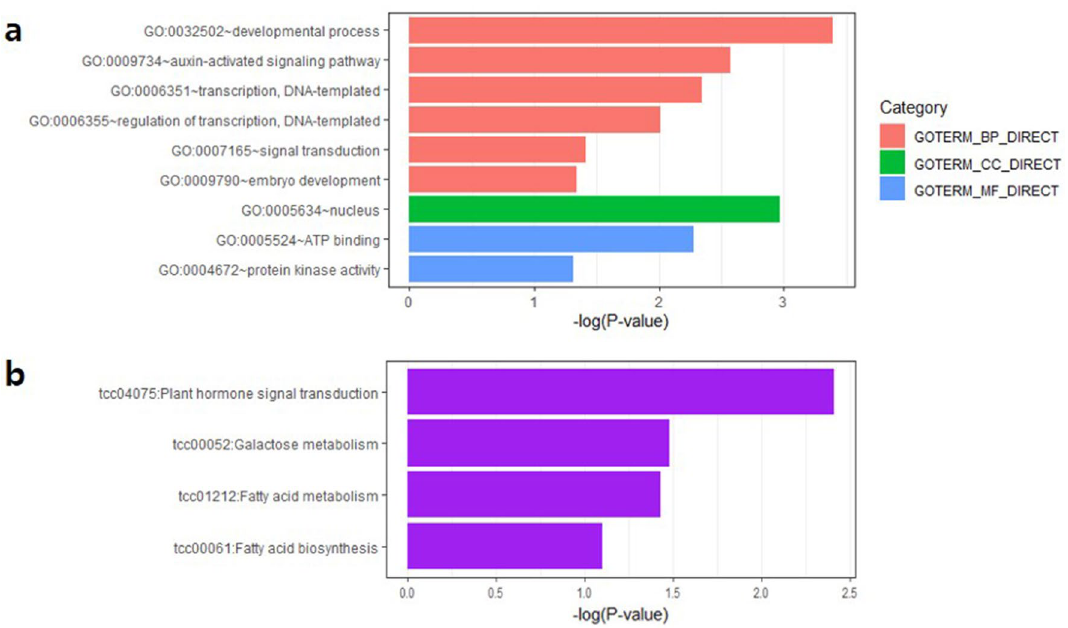
Figure 4. GO and KEGG enrichment analyses. ( a ) Assignment of DEGs into the GO categories ( b ) Clustering of DEGs into KEGG